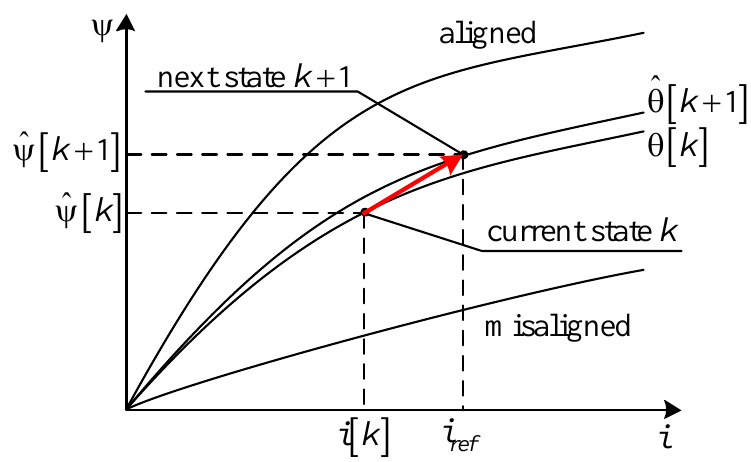
Figure 3. Current waveform for constant torque operation ( a ) and the phase A current reference surface example ( b ).